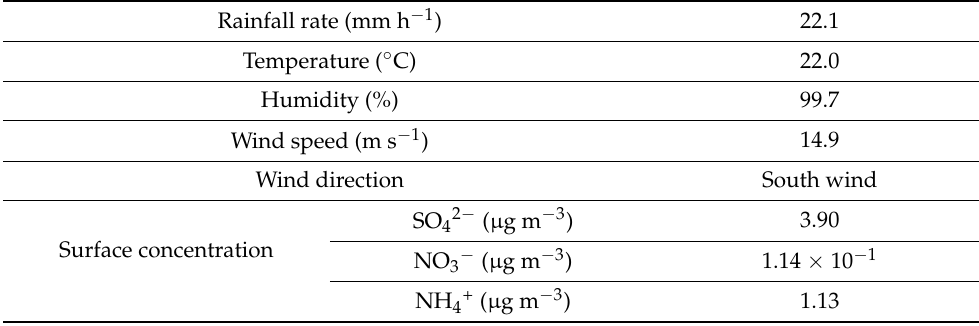
Table 3. Weather and boundary conditions for simulation at 2100 LST on 1 July 2016, from the Weather Research and Forecasting (WRF) and Community Multiscale Air Quality (CMAQ) models.